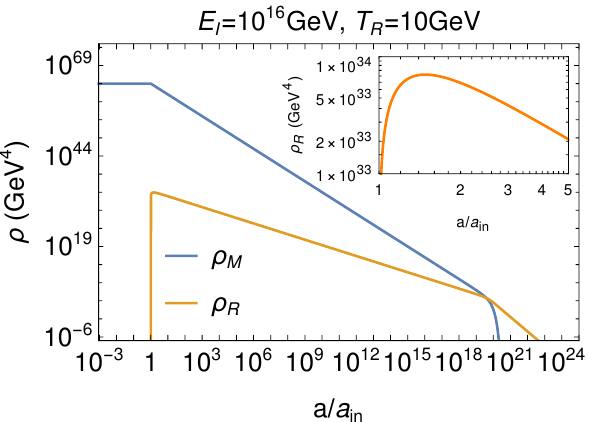
Figure 3. Inflaton (blue line) and radiation bath (orange line) energy densities as a function of the scale factor for inflationary reheating. In the top-right part of the plot we zoom in at early times and we show how the radiation bath energy density arises from inflaton